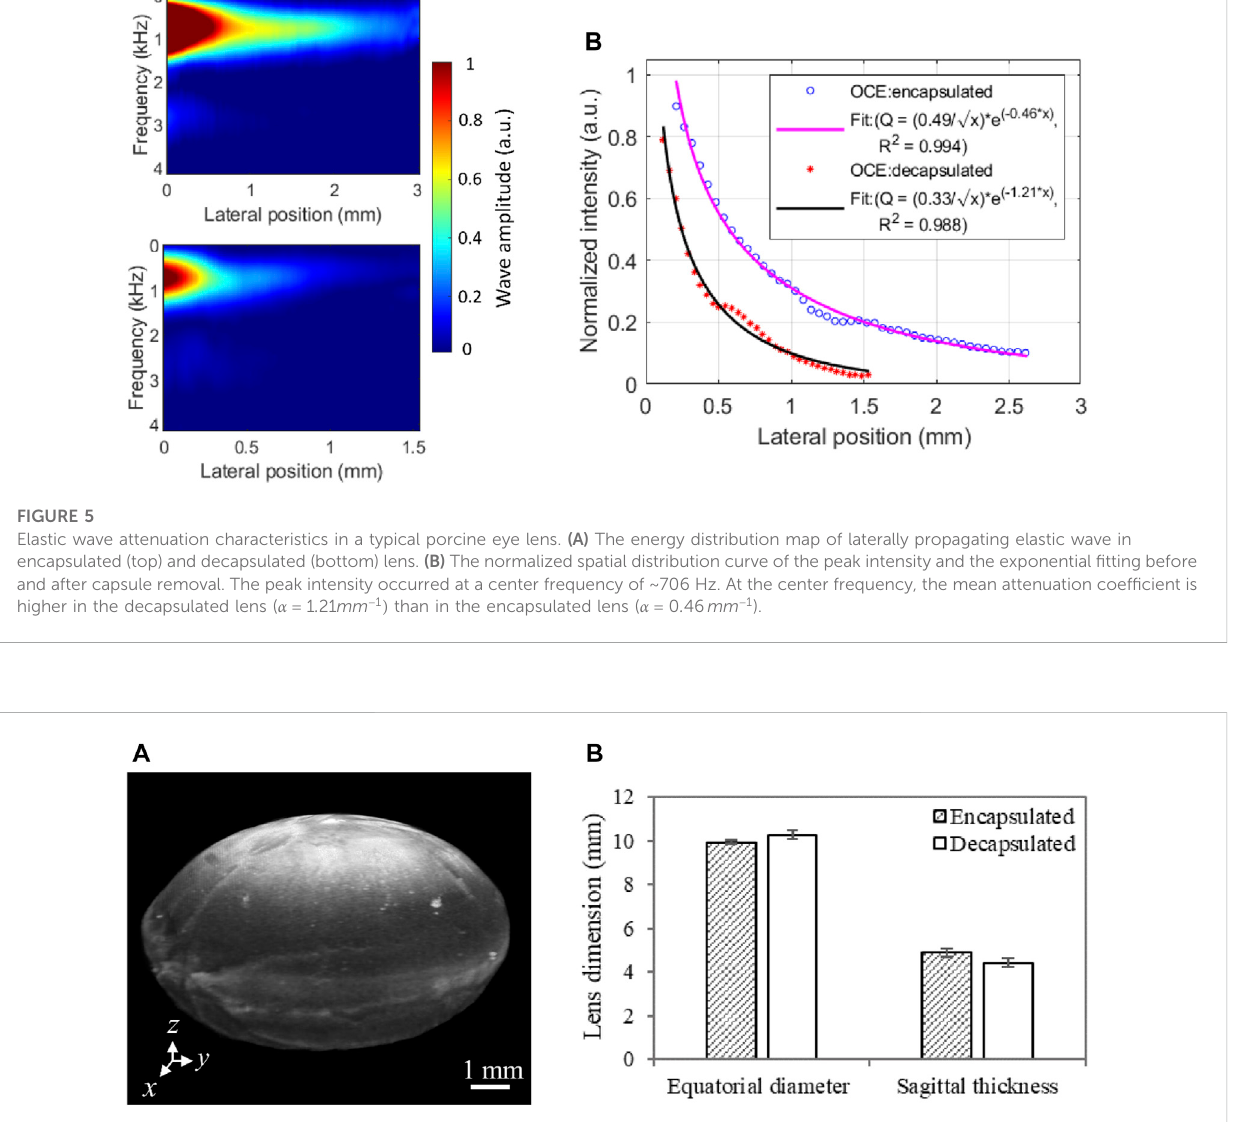
thickness with the removal of the capsule lead to an increase in the radius of curvature of the lens.